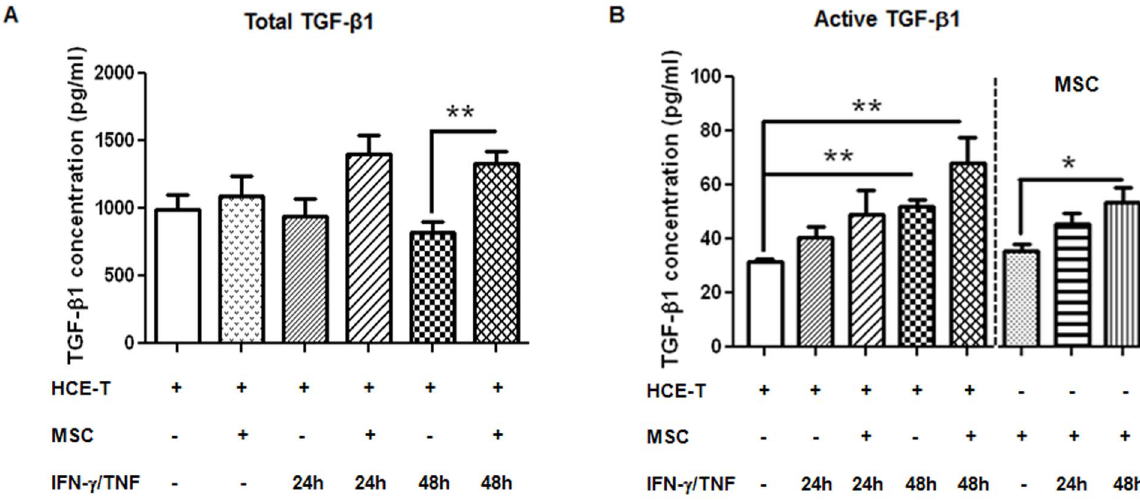
Figure 5. The effect of MSC on TGF- b 1 secretion. The concentration of ( A ) total and ( B ) active TGF- b 1 secretion in conditioned media collected from untreated HCE-T monocultures, MSC monocultures and HCE-T/MSC co-cultures, or HCE-T monocultures, MSC monocultures and HCE-T/MSC co- cultured with IFN- c /TNF stimulation for 24 h and 48 h was measured by ELISA. ( A ) A similar level of TGF- b 1 was detected from untreated HCE-T monocultures and HCE-T/MSC co-cultures. IFN- c /TNF-stimulated HCE-T/MSC co-culture showed increased total TGF- b 1 from HCE-Ts at 24 h (p=0.052), and significantly increased at 48 h (P , 0.01). ( B ) IFN- c /TNF treatment significantly increased active TGF- b 1 secretion from HCE-T (p , 0.01) and MSC (p , 0.05) monocultures at 48 h. Compared to untreated monocultures, IFN- c /TNF-stimulated HCE-T/MSC co-culture showed a significant increase in active TGF- b 1 after 48 h, (p , 0.05). Data represents the results from three individual experiments (n=3) 6 SEM. *: p , 0.05, **: p , 0.01. The ‘‘ + ’’ or ‘‘ 2 ‘‘ symbol denotes the presence or absence of the denoted treatment or cell type at the left.